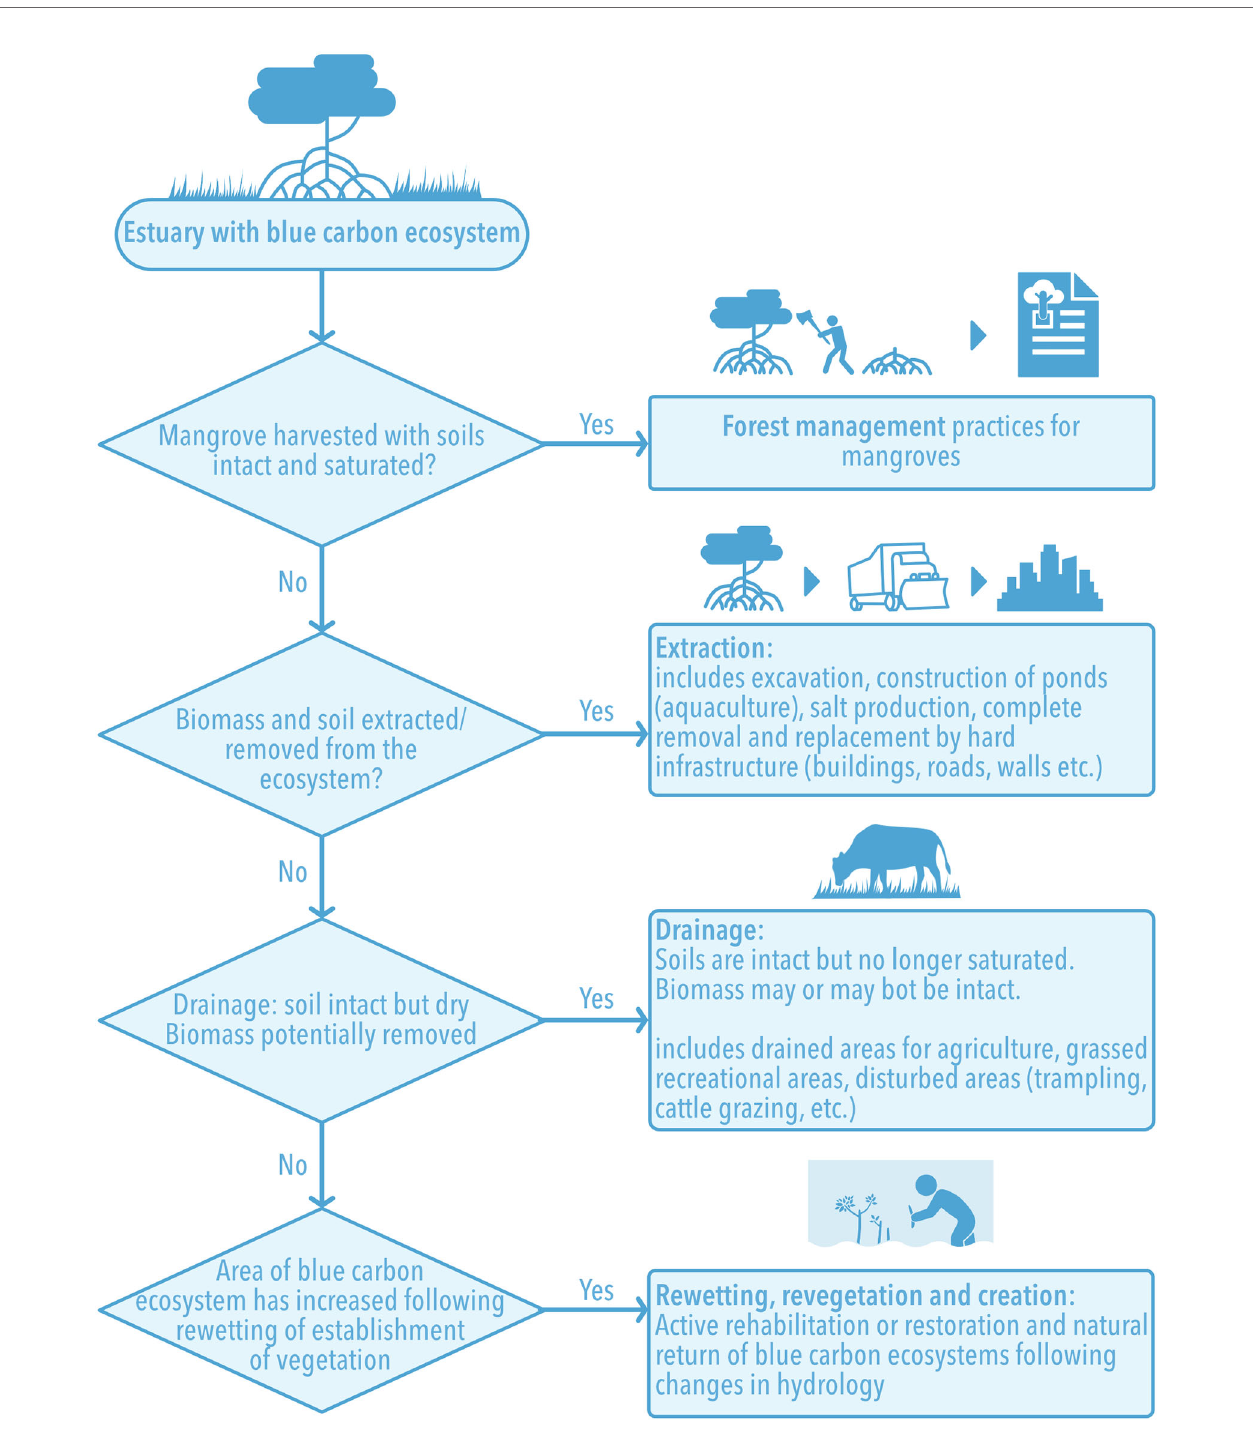
FIGURE 2 | Decision tree to assign reported changes in blue carbon ecosystems to the emissions and removals categories provided by the Hiraishi et al 2014 Wetlands Supplement. Adapted from (Hiraishi et al 2014 ).